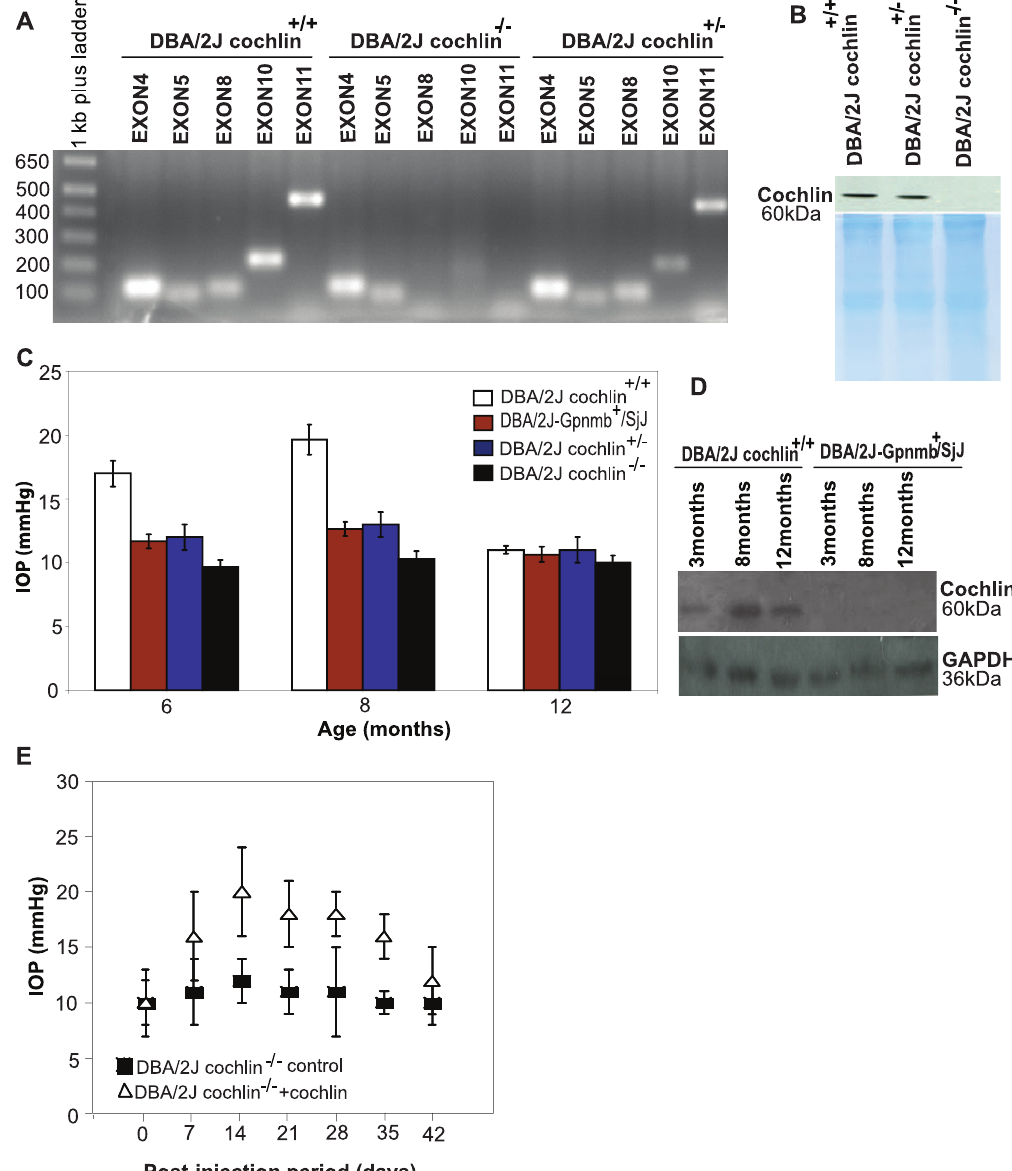
Figure 2. Down-regulation and/or disruption of cochlin expression in mice TM is commensurate with reduction in mean IOP. (A) Agarose gel (1.2%) showing the absence of PCR products for exons 8, 10 and 11 in the DBA/2J cochlin 2 / 2 mice. These exons are present in DBA/2J cochlin + / + and cochlin + / 2 mice. DNA was isolated from mice tail and subjected to PCR amplification for the indicated exons. (B) Western blot analysis of TM extract of DBA/2J cochlin + / + , DBA/2J cochlin + / 2 and DBA/2J cochlin 2 / 2 mice showing the complete absence of cochlin in DBA/2J cochlin 2 / 2 mice. Coomassie blue stained gel shows equal loading of protein in all the lanes. (C) Intraocular pressure (IOP in mmHg) in different mice strains at indicated ages (n=35–45 for each strain at each age group). The DBA/2J cochlin + / + mice show a higher mean IOP as compared to DBA/2J-Gpnmb + / SjJ, DBA/2J cochlin + / 2 and DBA/2J cochlin 2 / 2 mice at 6 months and at 8 months of age. The difference is most marked at 8 months of age. By 12 months, the mean IOP is similar for the different strains. (D) Western blot analysis of the TM protein extract from the DBA/2J cochlin + / + and DBA/2J- Gpnmb + /SjJ at the indicated ages, probed for cochlin. GAPDH has been shown as a loading control. (E) Generation 10 (Gen 10) DBA/2J cochlin 2 / 2 at six months of age were injected with a lentiviral vector bearing the COCH-GFP transgene (n=20) or GFP alone (n=20) in the anterior chamber. The mice were followed and IOP recorded at the indicated time periods. Error bars (C and E) depict 6 standard deviation.